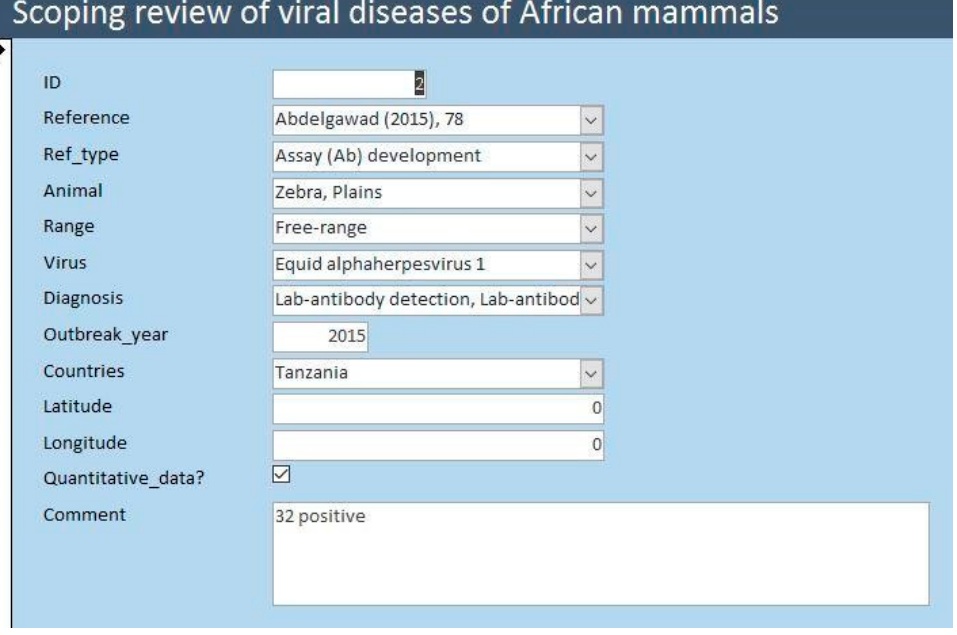
Figure A1. Screenshot of a Microsoft Access database form used to extract data from publications.